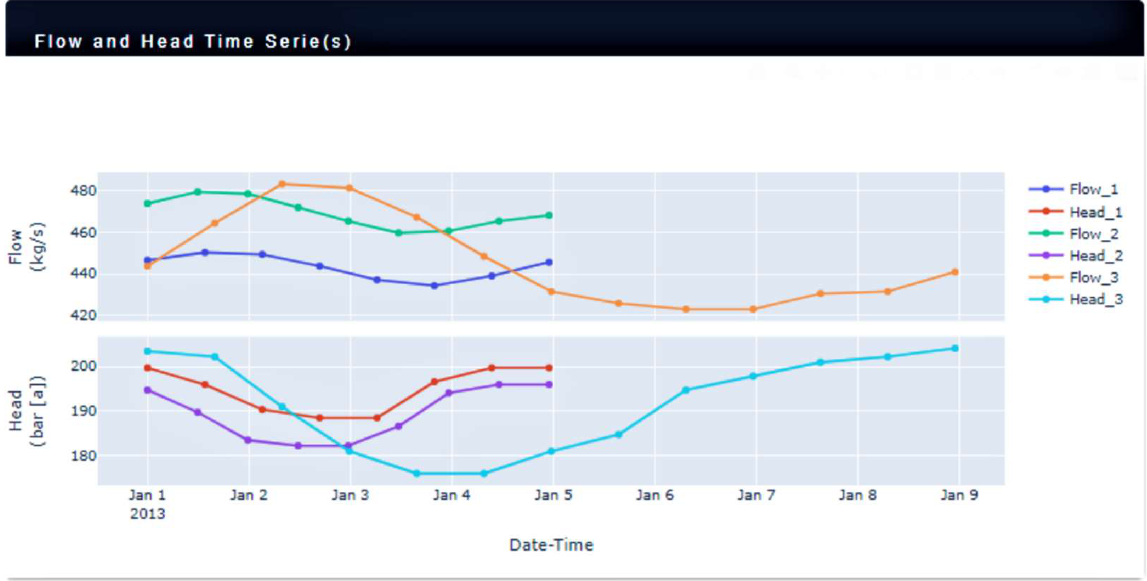
Figure 12. The user interface used to drive operational consequence decision support tool: trajectory is converted into flow and head time series.